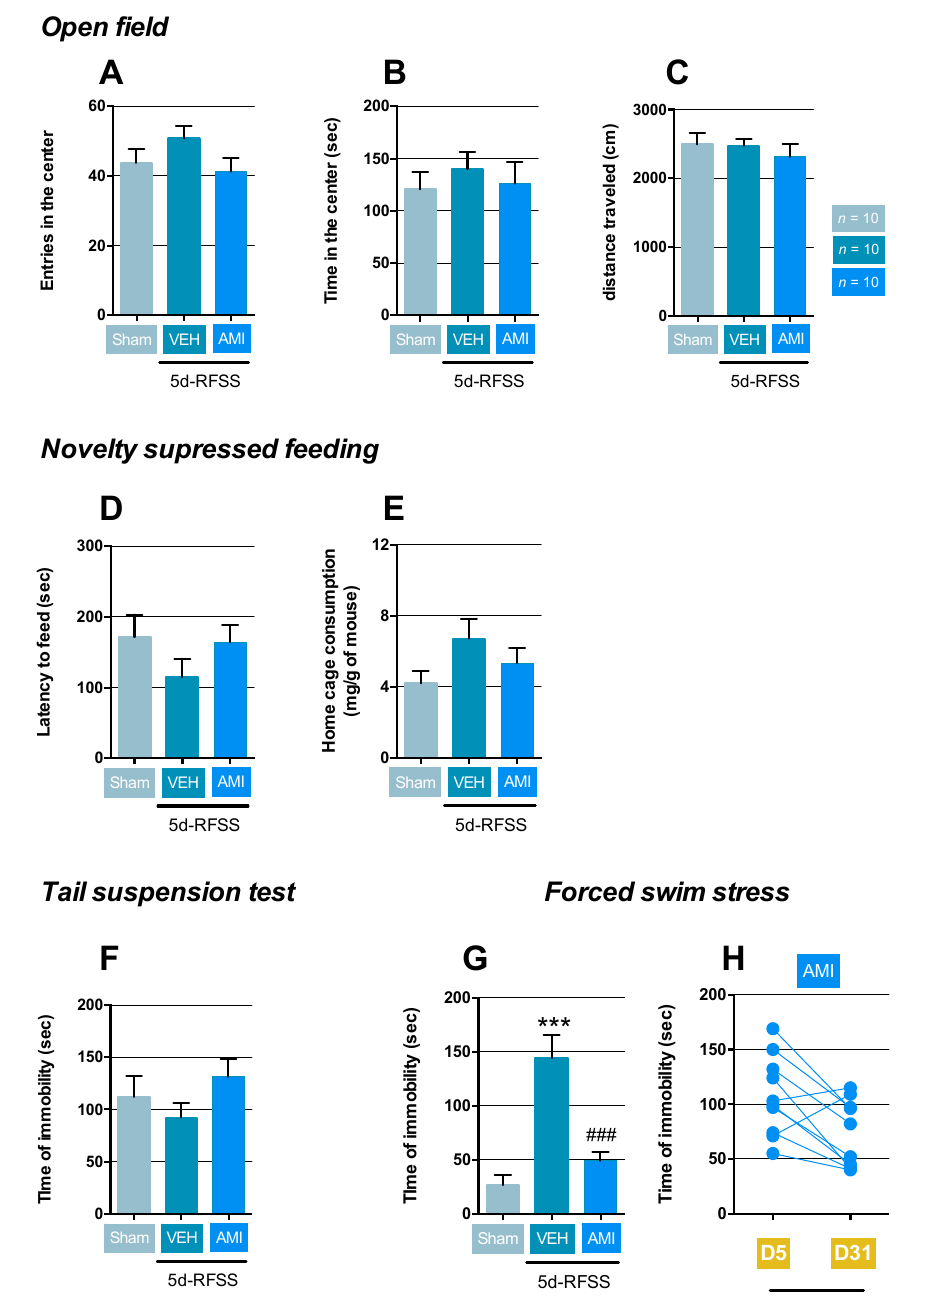
Figure 2. Behavioral characterization of 5d-RFSS on depressive-like symptoms in C57BL/6J mice. ( A – C ) Data are means ± SEM of number of entries and time spent (in sec) in the center the open field (OF) and, total distance travelled (in cm). One-way ANOVA did not show significant effect of treatment factor for each parameter: (F(2,27) = 1.76; p = 0.19), (F(2,27) = 0.3; p = 0.73), and (F(2,27) = 0.44; p = 0.64), respectively. ( D – E ) Data are means ± SEM of latency to feed (in sec) and food consumption (mg/g of mouse) in the novelty suppressed feeding (NSF). One-way ANOVA did not show significant effect of treatment factor for each parameter (F(2,27) = 1.1; p = 0.32) and (F(2,27) = 1.9; p = 0.16), respectively. ( F – G ) Data are means ± SEM of time of immobility (in sec) in the tail suspension test (TST) and forced swim test (FST). One-way ANOVA showed a significant effect of treatment factor for the TST (F(2,27) = 1.29; p = 0.28) but a significant effect for the FST (F(2,27) = 21.3; p < 0.001). ( H ) Individual data obtained in the 5d-RFSS/AMI group between the induction (D5) and test (D31) phases. n = 10 mice per group. *** p < 0.001: significantly different from control non-stressed mice (sham). ### p < 0.001: significantly different from 5d-RFSS mice using Fischer’s PLSD post-hoc